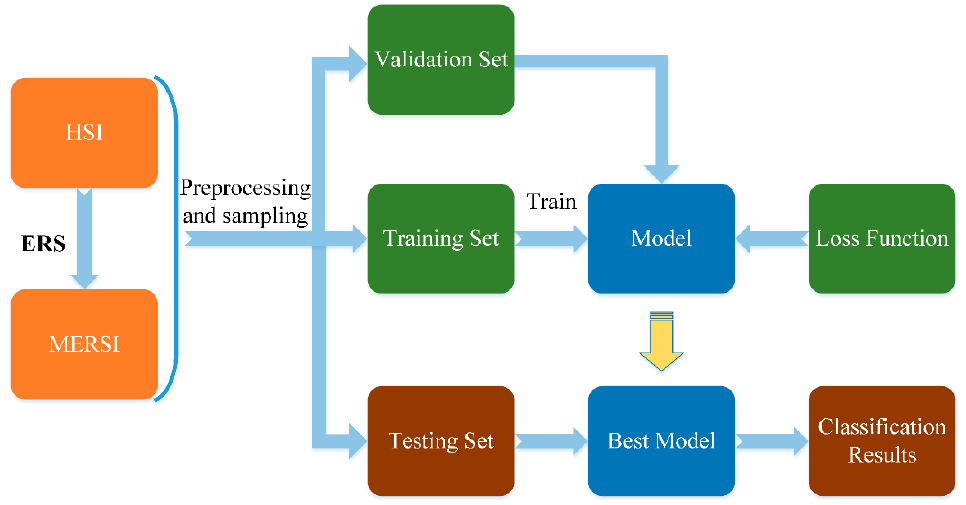
Figure 3. The overall process of TBN-MERS.